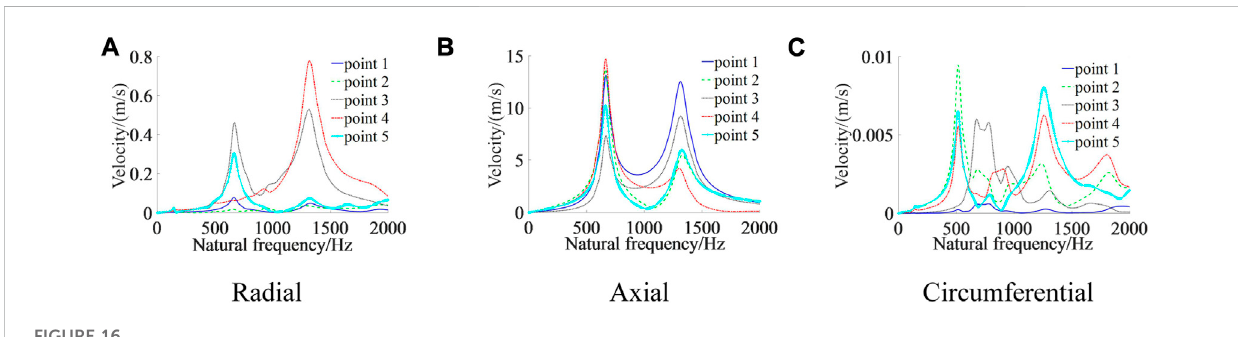
FIGURE 16 Velocity – frequency curve of the measurement